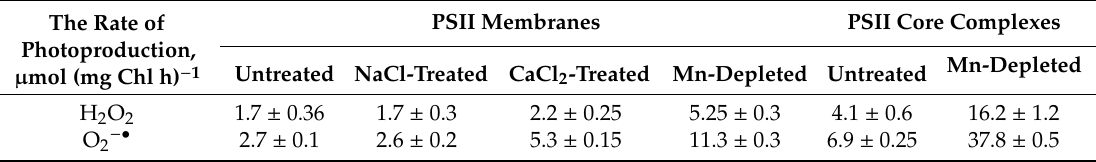
Table 2. The rate of H 2 O 2 and O 2 −• photoproduction in PSII preparations after various modifications of the water-oxidizing complex. The rates were calculated for 30 s after the start of illumination ( λ > 600 nm, 1500 µ mol photon m − 2 s − 1 ) of the samples. The Rate of